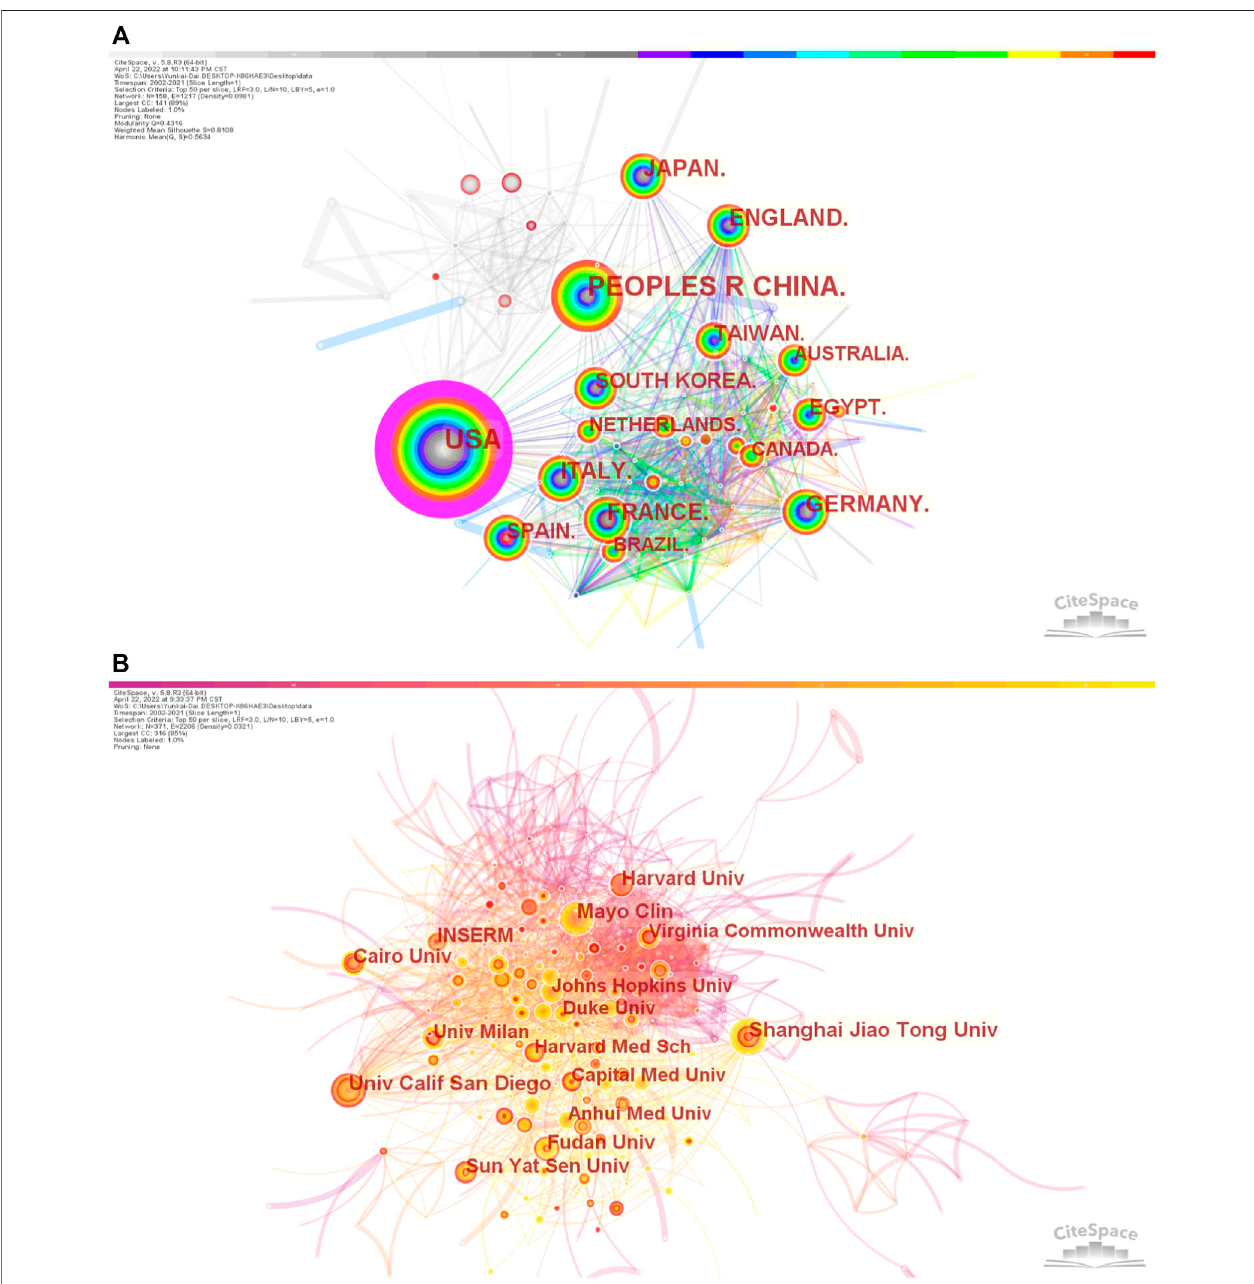
FIGURE3| Co-occurrencemaps (A) Countries; (B) Institutions.Notes:Thesizeofthenoderepresentstheco-occurrencefrequencieswhilethelinksre fl ecttheco- occurrence relationships. The color of node and line indicates different years.jpg.